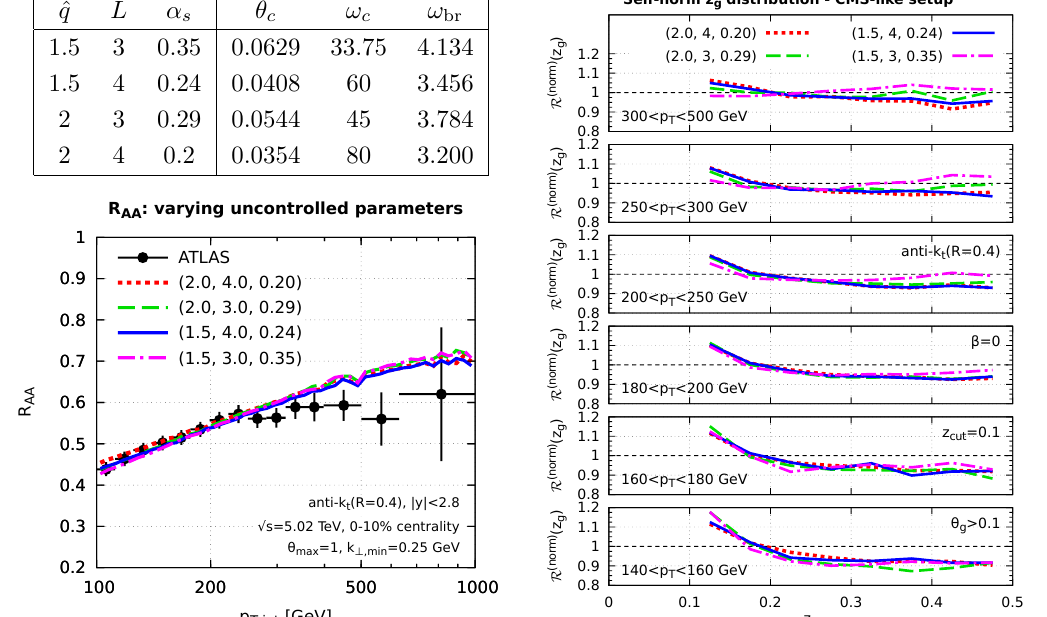
Figure 21 . Left: our MC results for jet R AA and for 4 sets of medium parameters which give quasi- identical predictions are compared to the ATLAS data [30] (black dots with error bars). Right: the MC predictions for the medium/vacuum ratio R (norm) ( z g ) of the self-normalised z g distributions are presented in bins of p T for the same 4 sets of medium parameters as in the left (cid:12)gure. space boundaries for VLEs by ! and (cid:18) . While the R ratio is most sensitive to variations c c AA in ! , small variations in ! ( (cid:24) 30% between our extreme values) can be compensated br br by larger variations of ! and (cid:18) (a factor (cid:24) 2 between our extreme values). Since the c c interplay between the 3 scales ! , ! and (cid:18) is di(cid:11)erent for R and R (norm) ( z ), our c c g AA br